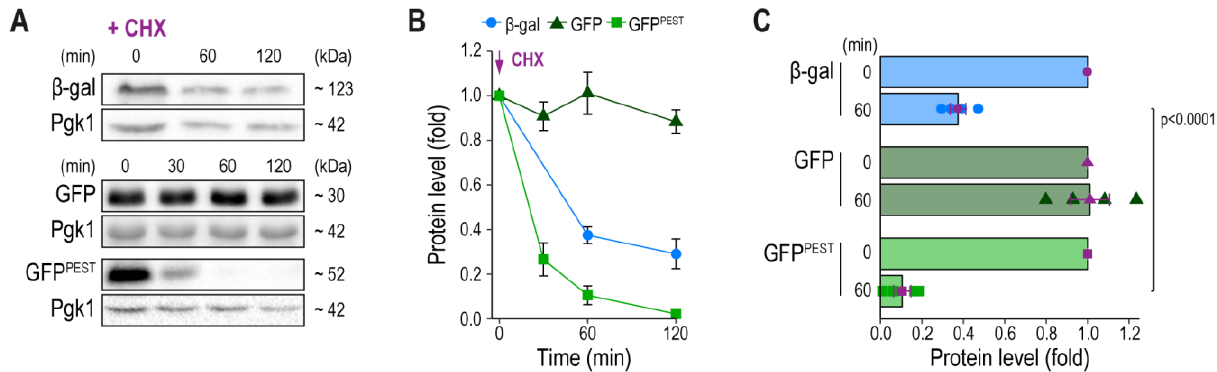
FIGURE 2: Reporter protein stability assessed via immunoblotting. (A-C) Representative immunoblots (A) and corresponding densitometric quantification (B, C) of reporter protein levels in exponentially growing cells lacking Pmr1 equipped with either pAMS366-4xCDRE-lacZ, pAMS366-4xCDRE-GFP or pAMS366-4xCDRE-GFP PEST at indicated times points after addition of cycloheximide (CHX) to a final concentration of 100 mg/L . Blots were decorated with antibodies against β -galactosidase or GFP, respectively, and Pgk1 as loading control. Molecular weight (kDa) as estimated by Page Ruler Protein standard. Values represent fold to t = 0 min. Means ± SEM, n =